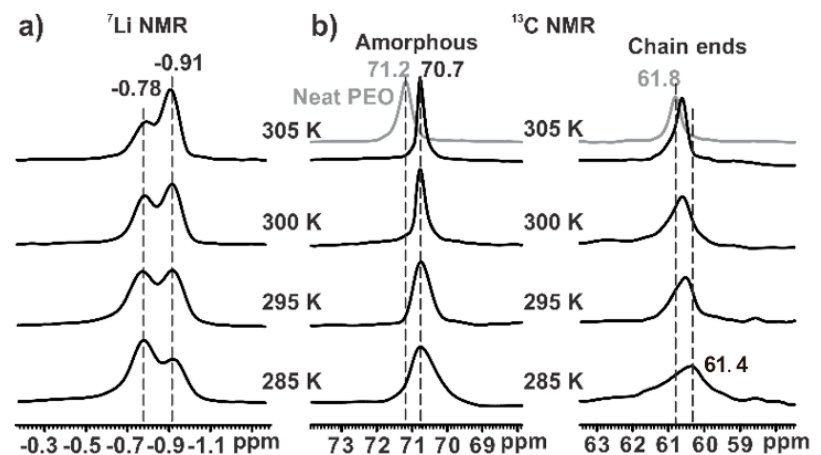
Figure 5. The temperature ‐ dependent ( a ) 7 Li and ( b ) 13 C single pulse excitation spectra of IM240 ‐ PEO/Li + . The 7 Li NMR spectra were acquired using a recycle delay of 150 s to ensure the full relaxation of the signals. The 13 C NMR spectra were acquired using a modified single excitation pulse sequence (see Figure 2). The relaxation delay was 0.05 s to suppress the crystalline signal. The experimental temperature ranges from 285 to 305 K. For comparison, the 13 C NMR spectra of neat PEO are shown.